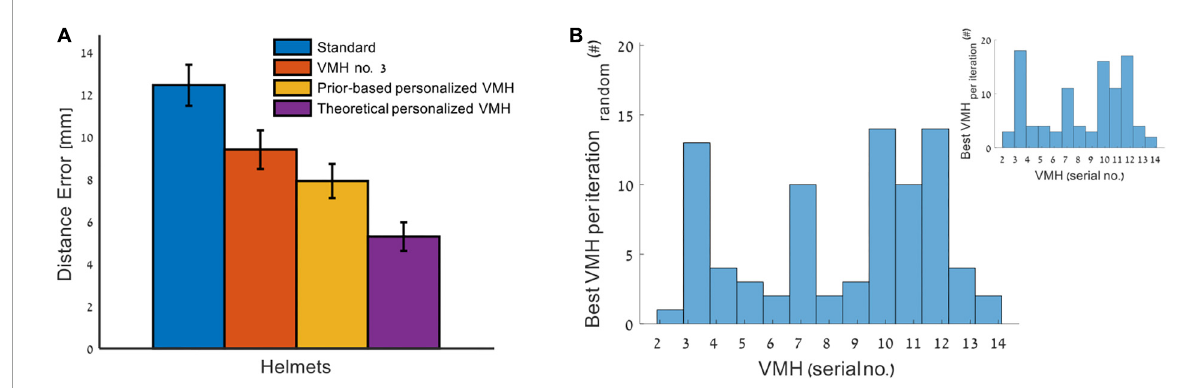
FIGURE5 Comparing personalized VMH to standard MEG helmet. (A) A mean ± SEM of distance error across 100 dipoles pairs minus the excluded 18 cases where no VMH outperform the others in source estimation accuracy. The bars represent: standard helmet (blue), the overall best specific VMH (serial no. 3, see Table 1 ) (red), the prior-based personalized VMH (per dipole pair, the selected VMH based on simulated previous recording) (yellow) and theoretical personalized VMH (based on apriori knowledge of source locations) (purple). Statistical test was only conducted for the comparison between the standard helmet to prior-based personalized VMH, to avoid circular inference. (B) A distribution of the evaluated VMHs, each count represents a dipole pair for which the specific VMH was selected. For 18 dipole pairs out of 100, no VMH was selected, as the source estimation accuracy of all evaluated VMHs was the same. In cases there were more than one, yet less than all, VMH that preformed the best ( Supplementary Figure 2 ), one VMH was randomly selected (inset: the distribution before random selection).